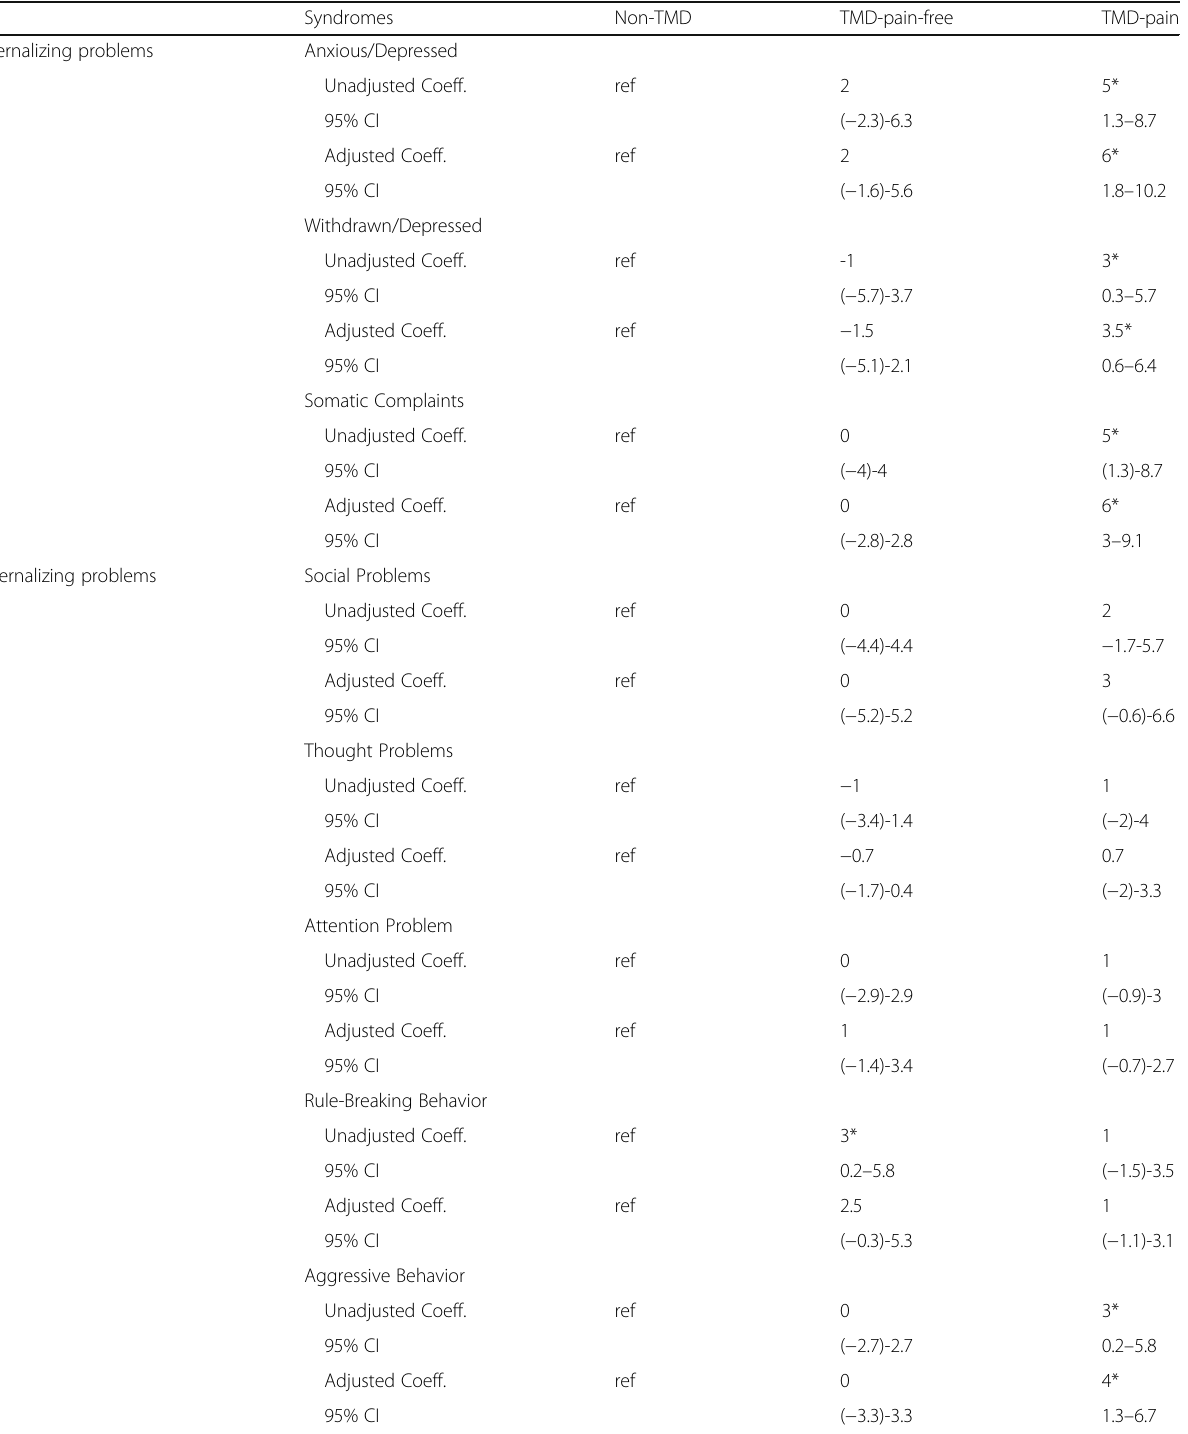
Table 3 Associations between TMD and eight narrow-band syndromes extracted from the child behavior checklist